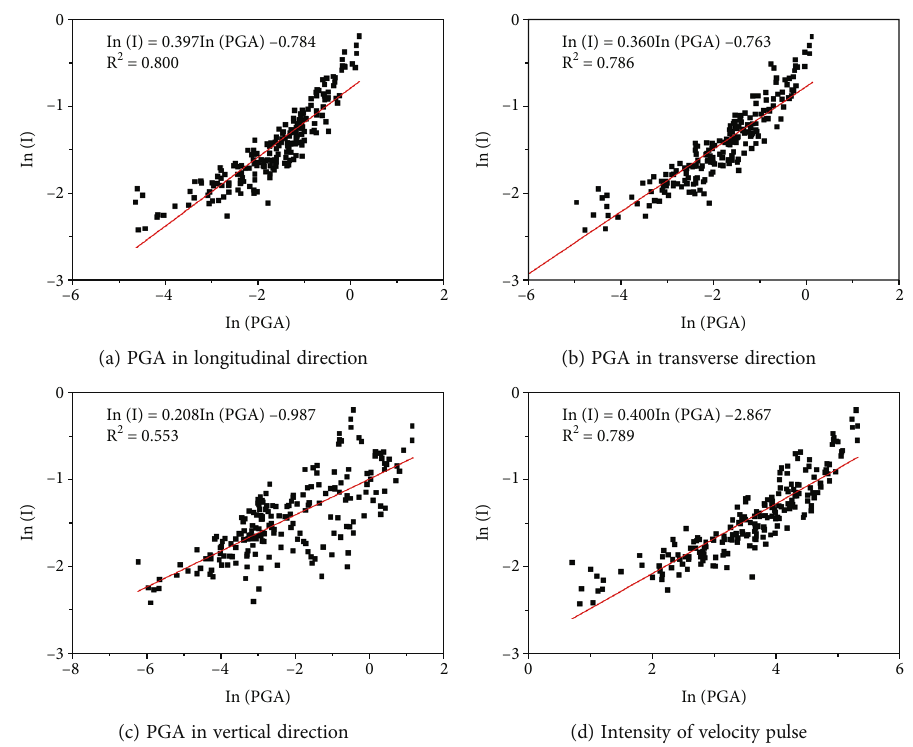
Figure 8: Plotted logarithmic relationship of intensity of near-fault ground motions vs. damage to the bridge.